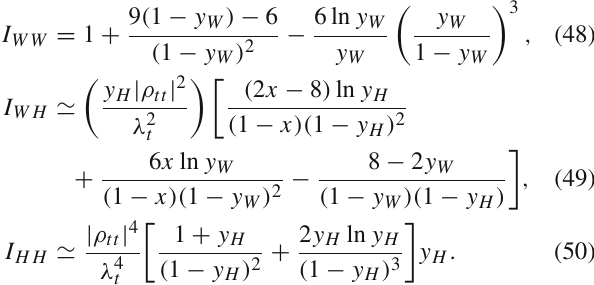
[65,66]. The ATLAS search [64] provides model indepen- dent 95% CL upper limit on cross section times branch- ing ratio ( σ( pp → ¯ tbH + ) × B ( H + → t √ s = 13 TeV 36 fb − 1 dataset for m H ± = 200 GeV– its 2 TeV. Likewise CMS also set 95% CL upper limits on σ( pp → ¯ t H + ) × B ( H + → t ¯ b ) , based on